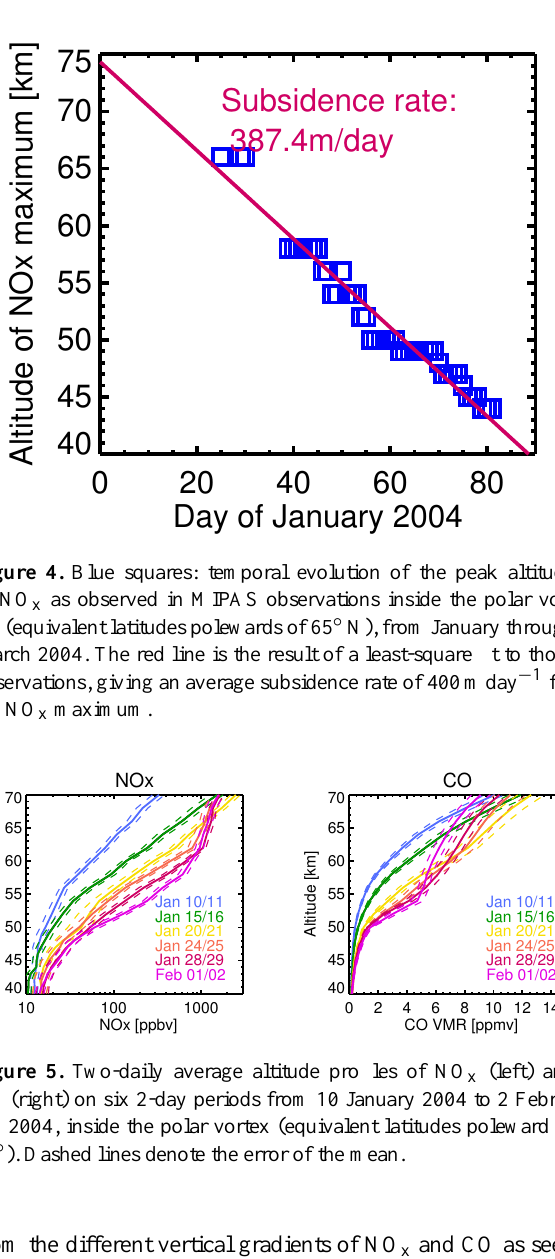
from the different vertical gradients of NO x and CO as seen in Fig. 5. The upper branch of the relationship with CO val- ues ≥ 10 ppmv and NO x values ≥ 700 ppbv appears only af- ter 14 January, at altitudes above 60 km. Maximal values of more than 12 ppmv CO and more than 2000 ppbv NO x are reached on 18/19 January. The increase of both NO x and CO at the same time suggests downwelling of air from the upper mesosphere/lower thermosphere as a source. As maximum values of NO x are reached on 18/19 January, their source can therefore not be direct production during the strong geomag- netic storm of 22 January as suggested, e.g., by Renard et al. (2006). In the left panel of Fig. 6, the secant to the NO x –CO re- Fig.6. ScatterplotofNOxandCOasobservedbyMIPASwithinthepolarvortexthroughoutNHwinter2003–2004. Left: FromNovember 15, 2003 to January 19, 2004, considering observations in the altitude range 40–70km. The symbols are color-coded by time, with blue lationship is marked as a dashed line. The region denotingdaysin2003,andthedaysinJanuary2004runningfromgreen-yellow-orange-red. DarkredisJanuary19. Thedashedlinemarks the secant to this distribution, light grey marks the region incorporated by the observed distribution and its secant. Right: from January 20 to March 1, 2004. Grey area and dashed line as in left panel. Colors mark the day, running from dark blue – green – yellow – orange – red. ErrorbarsshowtheerrorofthemeanofthedailyaveragesofNOx.